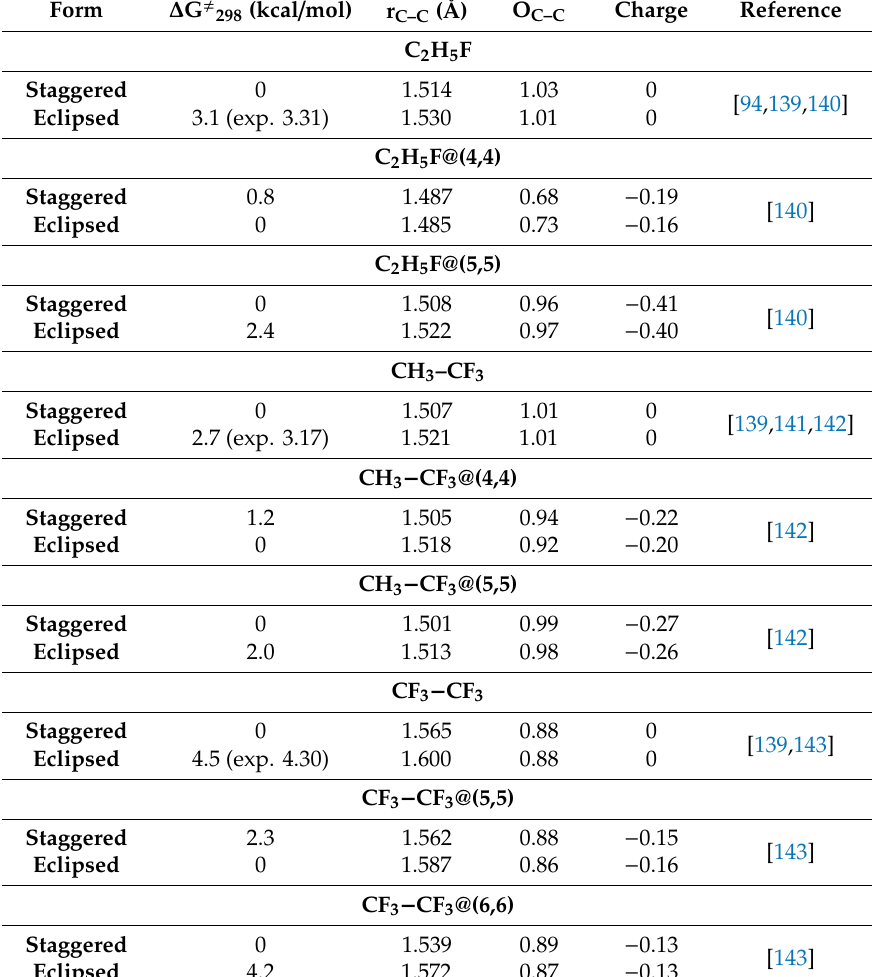
Table 2. Energetical and structural parameters of fluoroethanes (PBE / 3 ζ